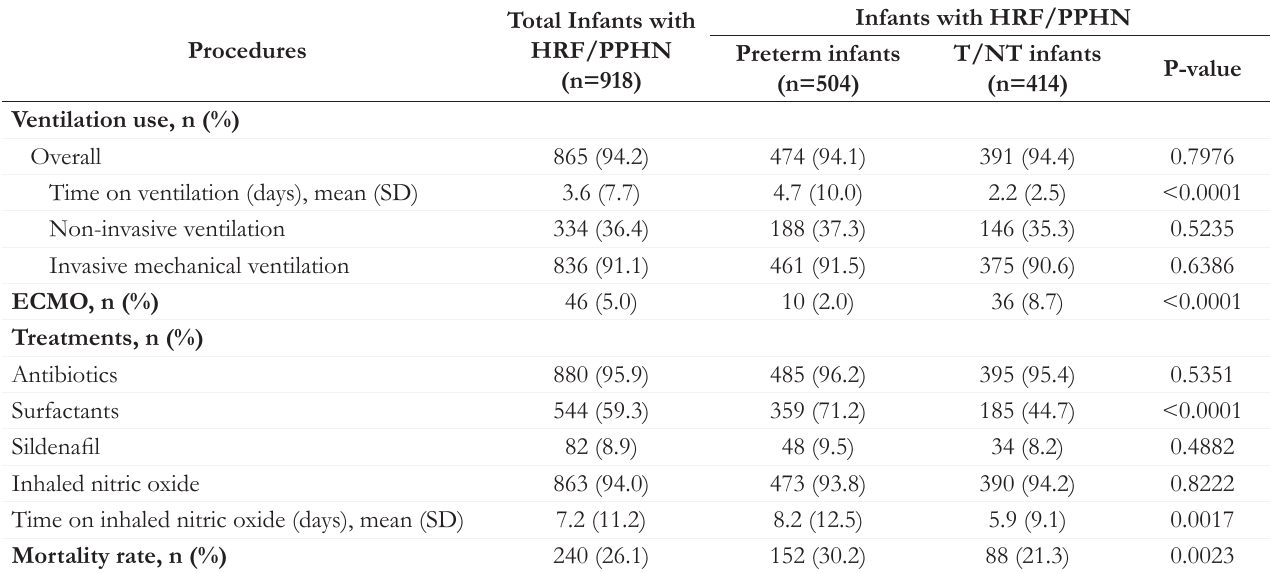
Table 2. Procedures and Treatments Among Infants diagnosed with